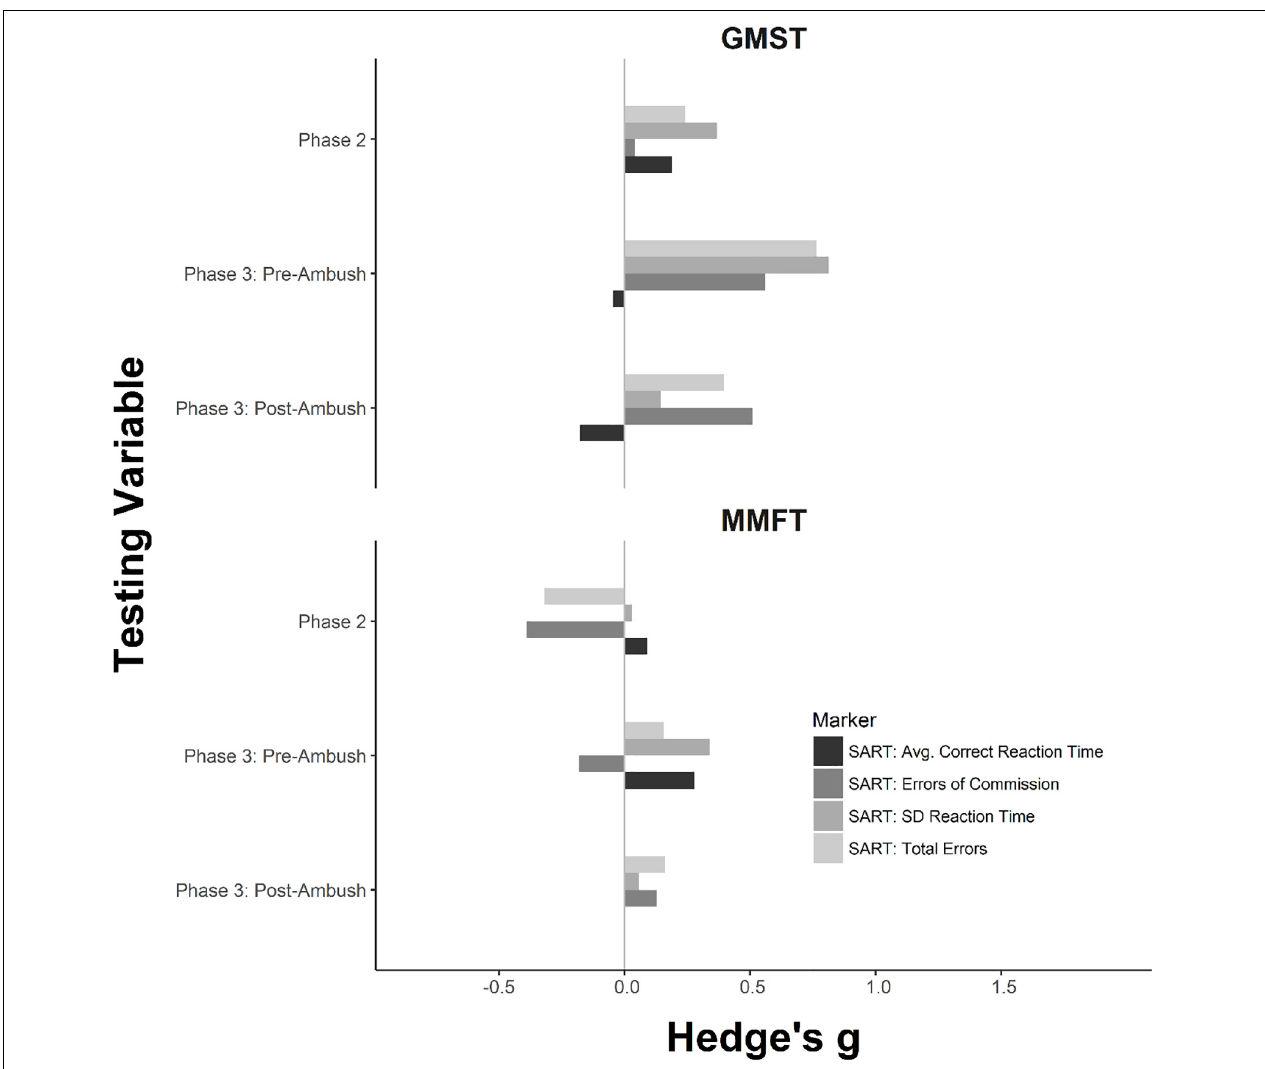
FIGURE 1 | Sustained Attention to Response Task effect size comparison of group differences between General Mental Skills Training (GMST), Mindfulness-Based Mind Fitness Training (MMFT), and Training-as-Usual (TAU). The horizontal axis represents the Hedge’s g for each observation. The vertical axis represents the measured variable. Zero indicates no difference between the MST group and TAU. Larger positive effect sizes, indicated by a bar to the right beyond 0, indicate desired differences for MMFT and GMST when compared to TAU. Negative effect sizes, indicated by a bar to the left beyond 0, indicate an undesired effect when compared to